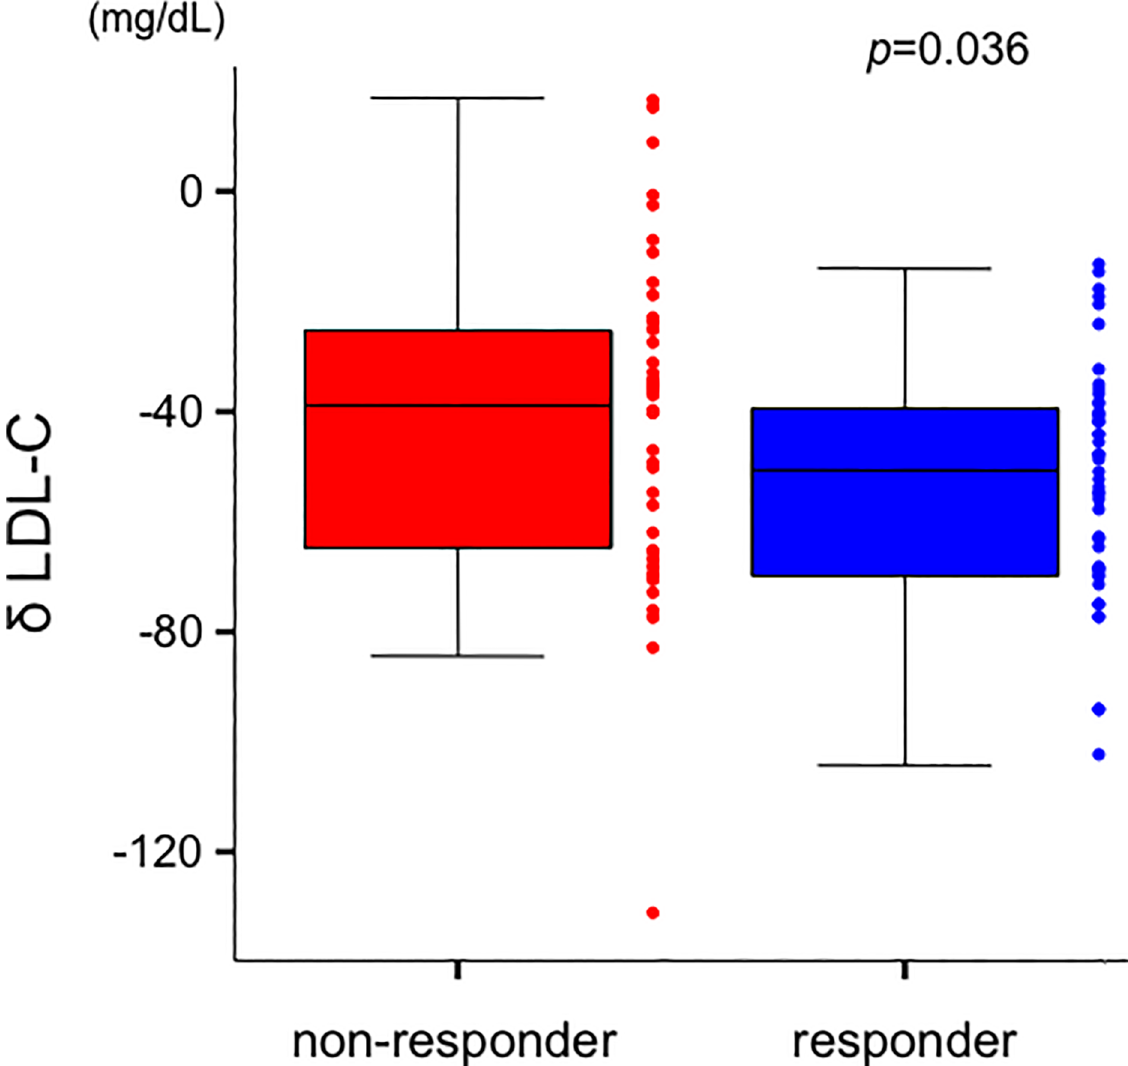
Fig 2. Comparison of δ LDL-C levels between the 2 groups. δ LDL-C levels in patients with responder group were greater than those in non-responder group (responder: − 53 ± 21 mg/dL vs. non-responder: − 42 ± 29 mg/dL, p = 0.036). Data are presented as box and whisker plots with median and 25th to 75th percentiles (boxes) and 10th to 90th percentiles (whiskers). LDL-C = low-density lipoprotein cholesterol.